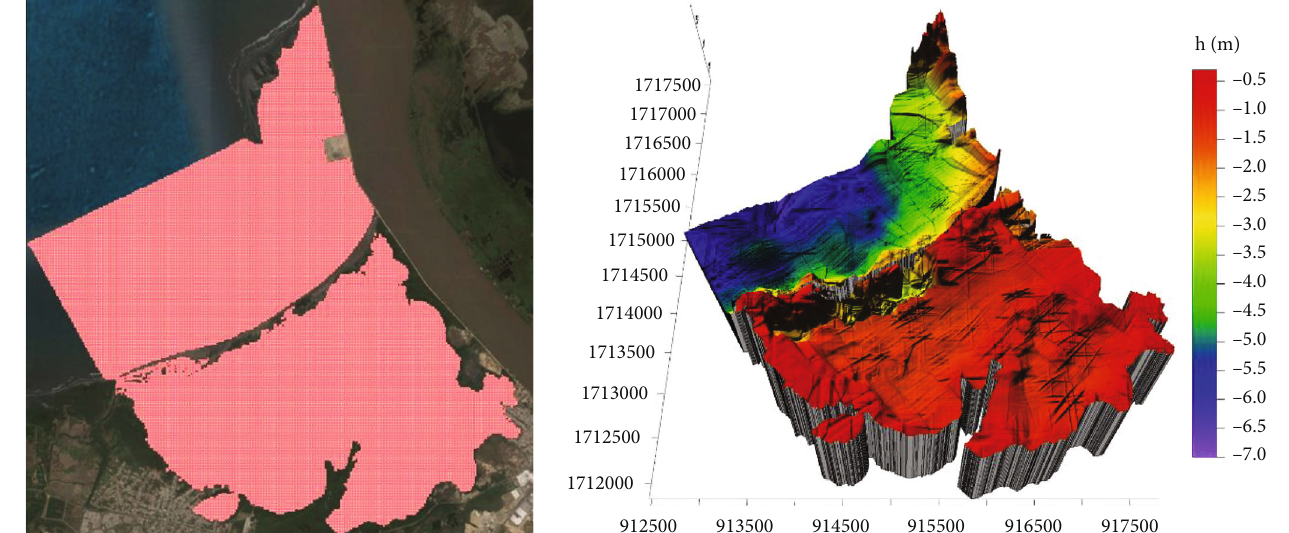
Figure 6: Discretized study domain: (a) Numerical grid for coastal lagoon. (b) Bathymetry for coastal lagoon zone.